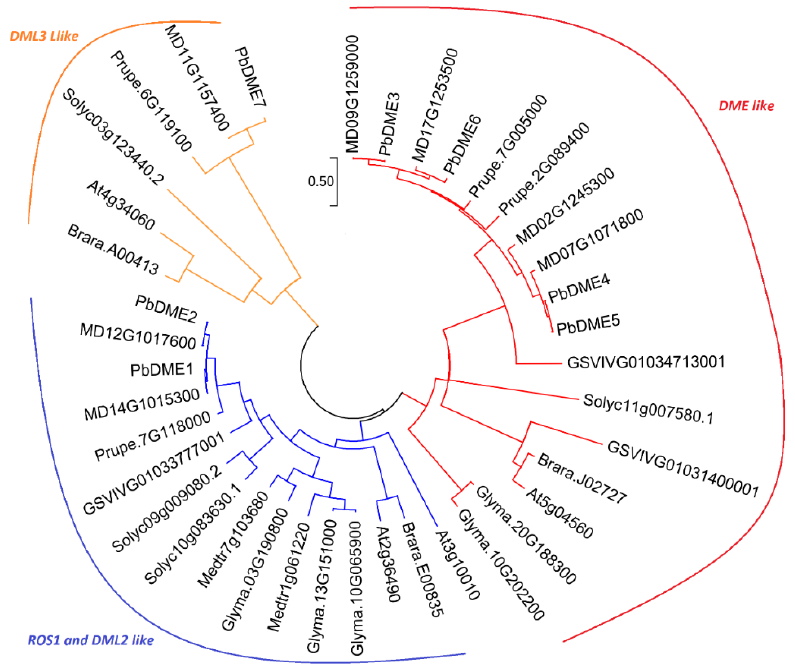
Figure 2. Evolutionary relationships of the DME gene family in nine plant species. The evolutionary analysis included the DME genes from Pyrus. bretschneideri and eight other species: Arabidopsis. thaliana , Malus. domestica , Prunus. persica , Brassica. rapa , Glycine. max , Medicago. truncatula , Vitis. vinifera , and Solanum. lycopersicum . Different groups are illustrated in different colors. The evolutionary history was inferred using the neighbor-joining method with 1000 bootstraps in MEGA 7.0 [60].